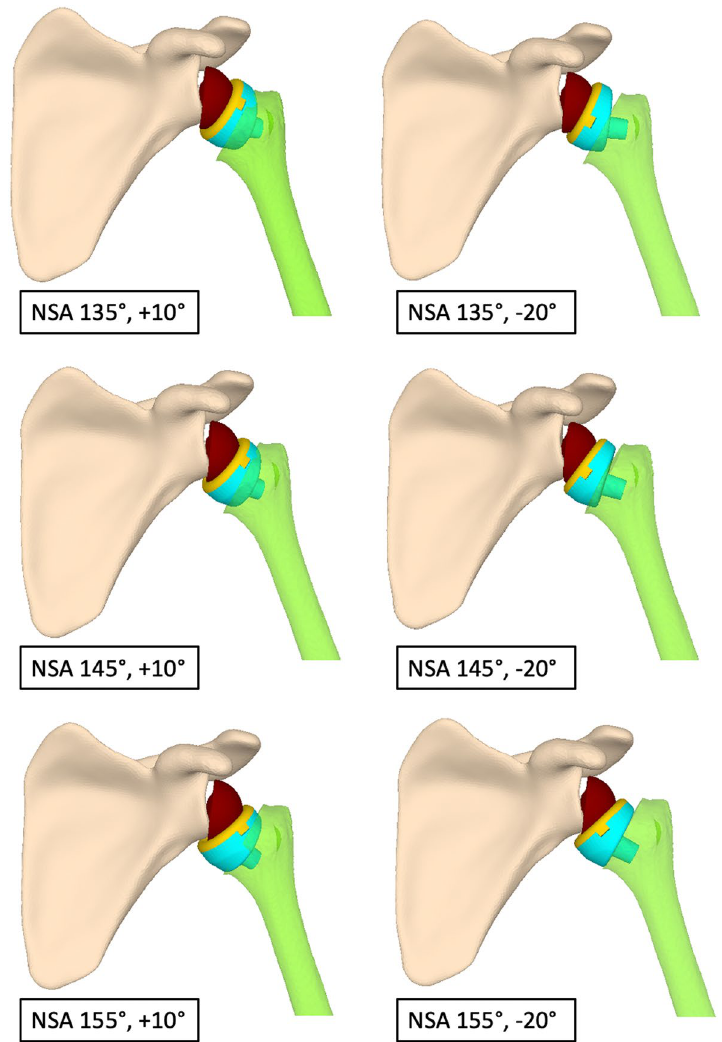
Fig. 3 The different combinations of NSA and humeral torsion that were tested